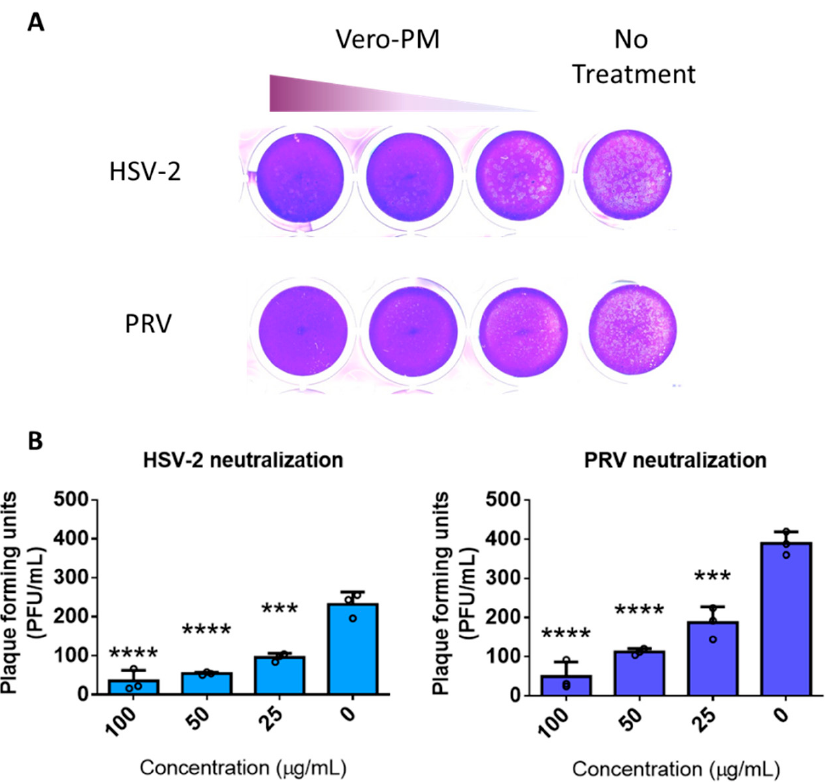
Figure 5. Vero-PMNPs are effective in neutralizing other herpesviruses: ( A ) A plaque reduction assay showing a concentration-dependent reduction in plaques for samples neutralized with Vero-PMNPs. ( B ) Quantification of viral plaques for both HSV-2 and PRV. Experiments were performed in triplicates. A non-parametric, one-way ANOVA analysis was performed comparing to a non-treated sample. *** p < 0.001, **** p < 0.0001.